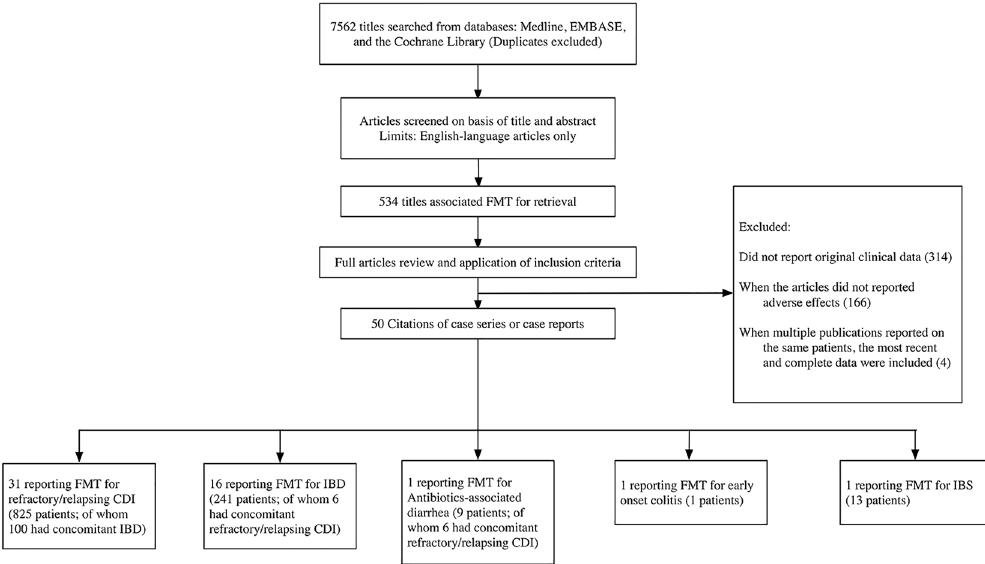
Fig 1. Flow chart of studies of adverse events of fecal microbiota transplantation. FMT: fecal microbiota transplantation, CDI: Clostridium difficile infection, IBD: inflammatory bowel disease, IBS: irritable bowel